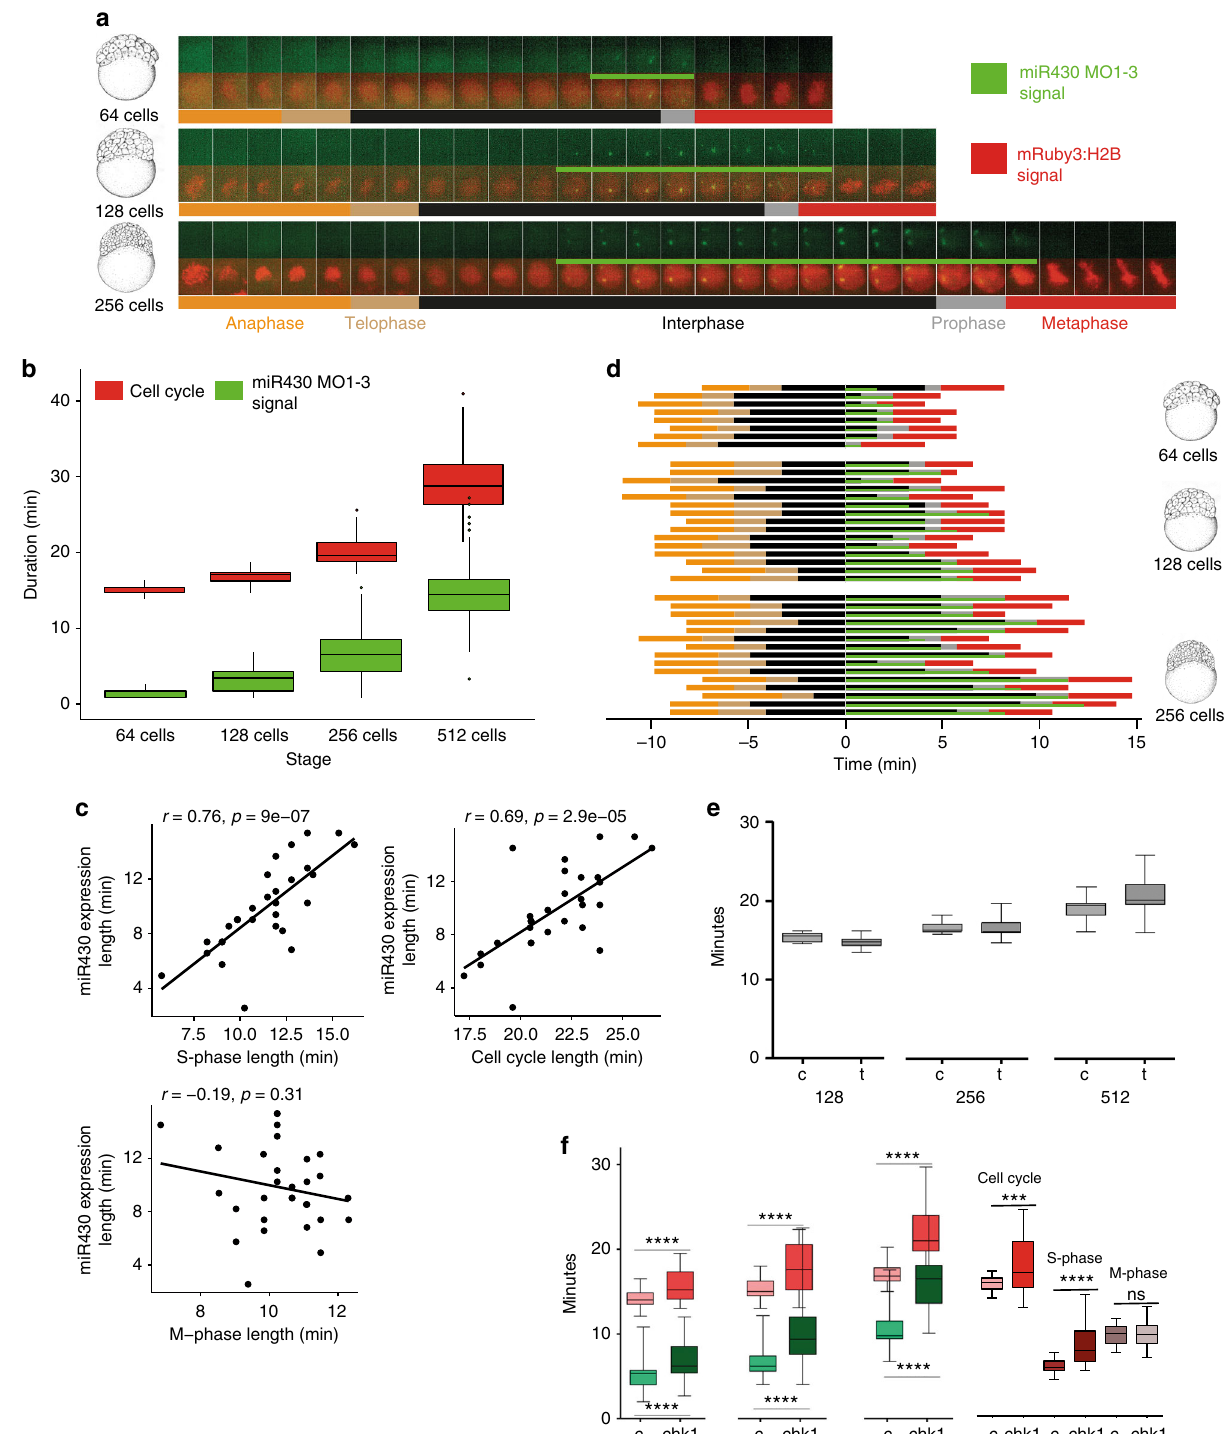
(Fig. 4e). In contrast, when precocious Checkpoint kinase 1 (Chk1) activation was forced by injecting synthetic chk1 mRNA 32,33 , signi fi cant elongation of the cell cycle in cleavage stage embryos and corresponding elongation of miR430 MO signal were detected in every cleavage cycle measured (Fig. 4f, Supplementary Fig. 3b,c). This elongation of the cell cycle was due to changes in S-phase as no signi fi cant changes were seen during M-phase (Fig. 4f). Thus, cell cycle elongation is permissive